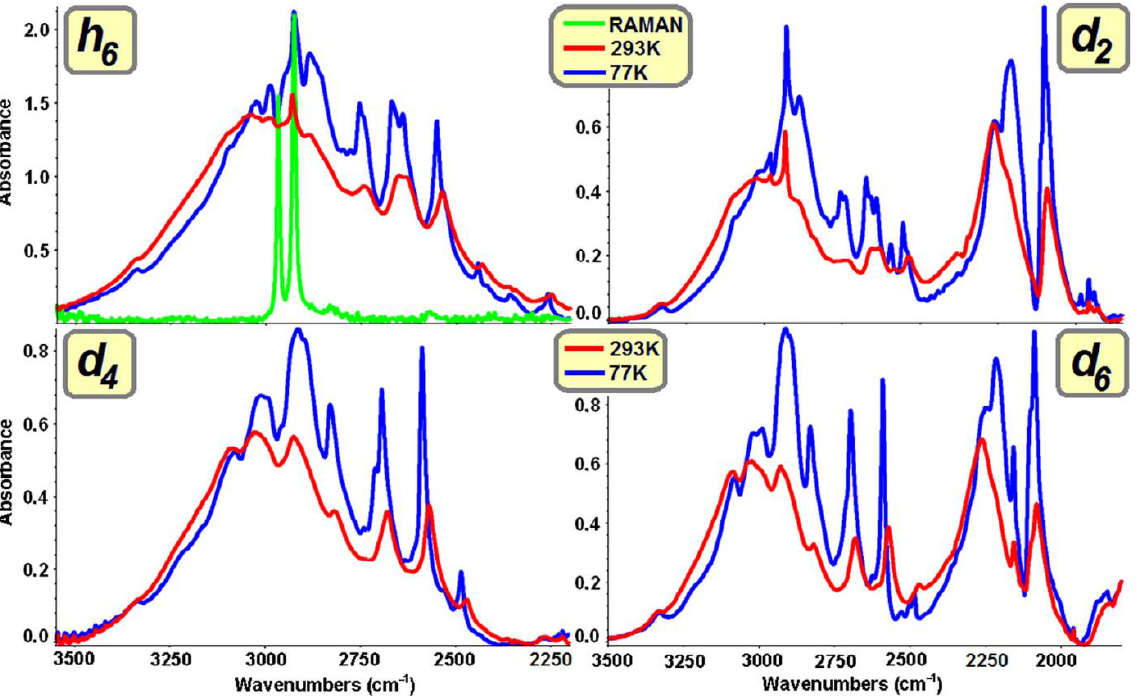
Figure 6. Infrared and Raman spectra of polycrystalline samples of succinic acid isotopic varieties, with a visible distinction between the ν X – H and ν X – D bands [27].